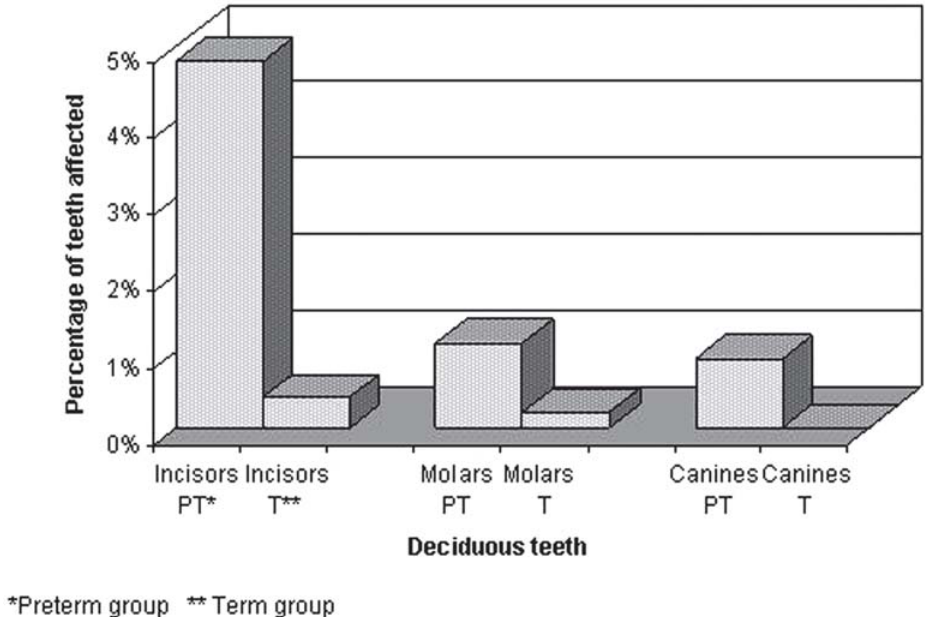
FIGURE 1- Percentage of incisors, molars and canines of the preterm and full-term groups affected by hypoplasia according to number of teeth